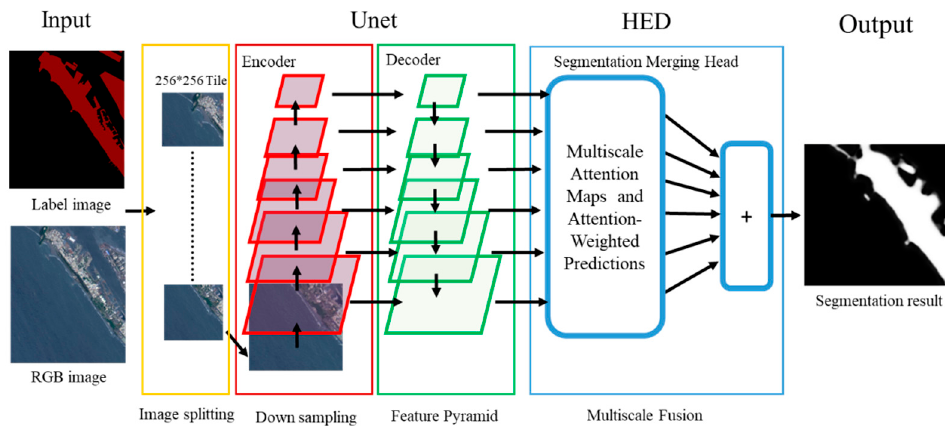
Figure 11. Flow chart of sea–land segmentation training with HED-Unet.